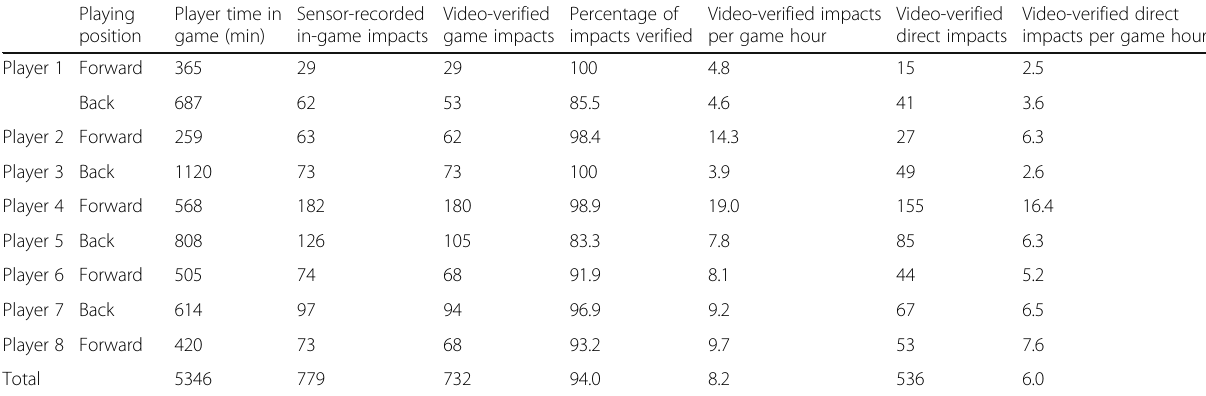
Table 2 Cross tabulation of frequency of verified in-game impacts measured by the x-patch ™ , video-verified impacts, player position, and game time Playing position